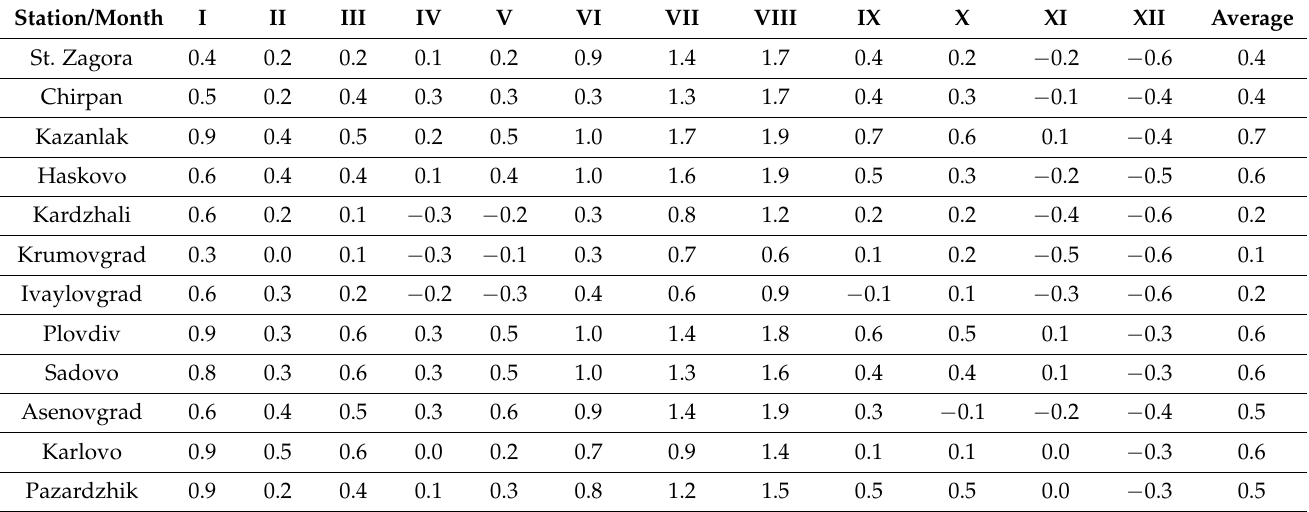
Table 6. Average monthly temperatures deviations in central south Bulgaria in the period 1986–2015.